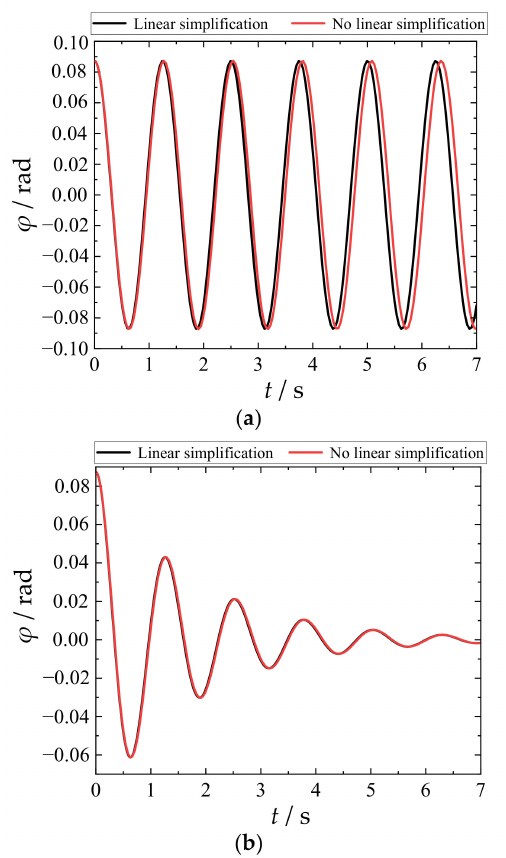
Figure 5. Dynamic response process for the load swaying angle. ( a ) k = 0. ( b ) k (cid:54) =